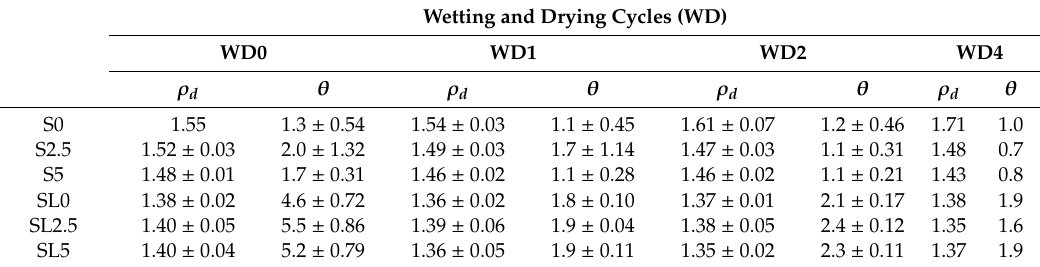
Table 3. E ff ect of the simulated WD cycles on the bulk density ( ρ d ) and volumetric soil water content ( θ ) on the sandy (S) and sandy loam (SL)